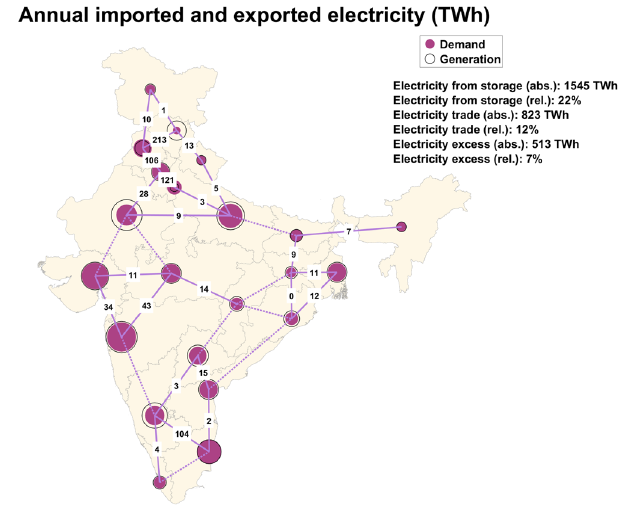
Fig. 6 | Inter-regional electricityexportsand imports across India in 2050. The annual net exchange of electricity across India is around 823 TWh, which is 12% of the electricity generated in 2050.